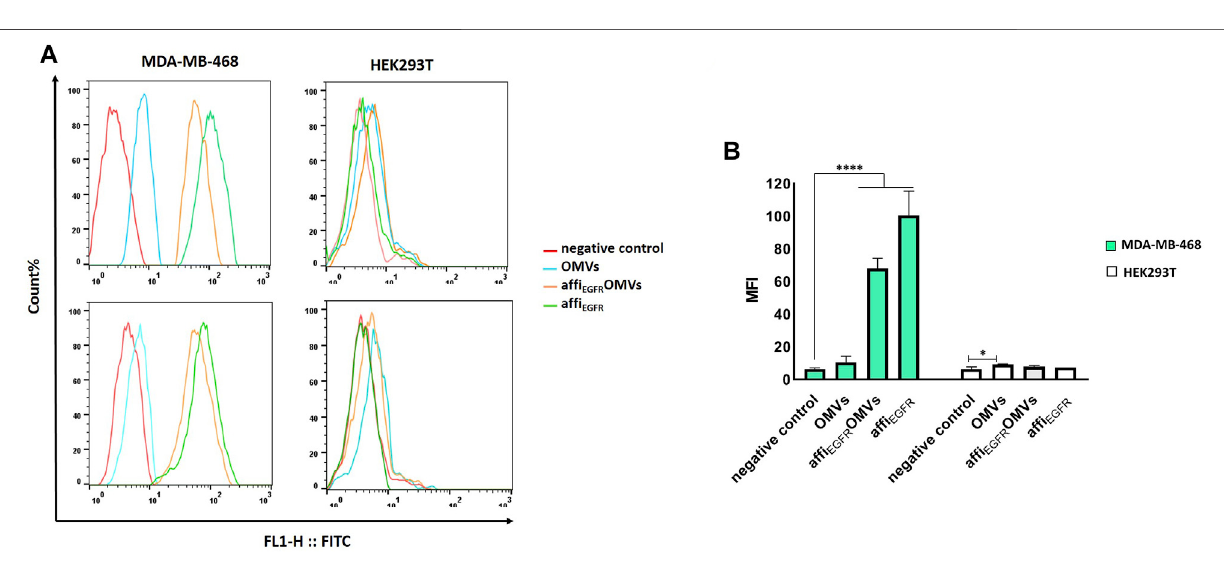
FIGURE 4 | Flow cytometric analysis of af fi EGFR -OMVs that bind to tumor cells. Analysis was carried out using OMVs and af fi EGFR -OMVs binding to MDA-MB-468 and HEK293T cells. (A) The af fi EGFR -OMVs and the puri fi ed af fi EGFR speci fi cally attach tothe EGFR-positive MDA-MB-468 cells as presented byshiftin the fl uorescence in MDA-MB-468 cells. (B) Plot of the MFI values in MDA-MB-468 and HEK293T cells incubated with the OMVs and the puri fi ed af fi EGFR -GALA. Mean Fluorescence Intensity (MFI) value of negative control, i.e., incubation with anti-af fi body and FITC-conjugated IgG alone, ruling out any unspeci fi c binding to the tumor cells. 5 × 10 5 numbers of cells per sample were recorded and MFIs are displayed as histograms. * p < 0.05, **** p < 0.0001 compared to negative